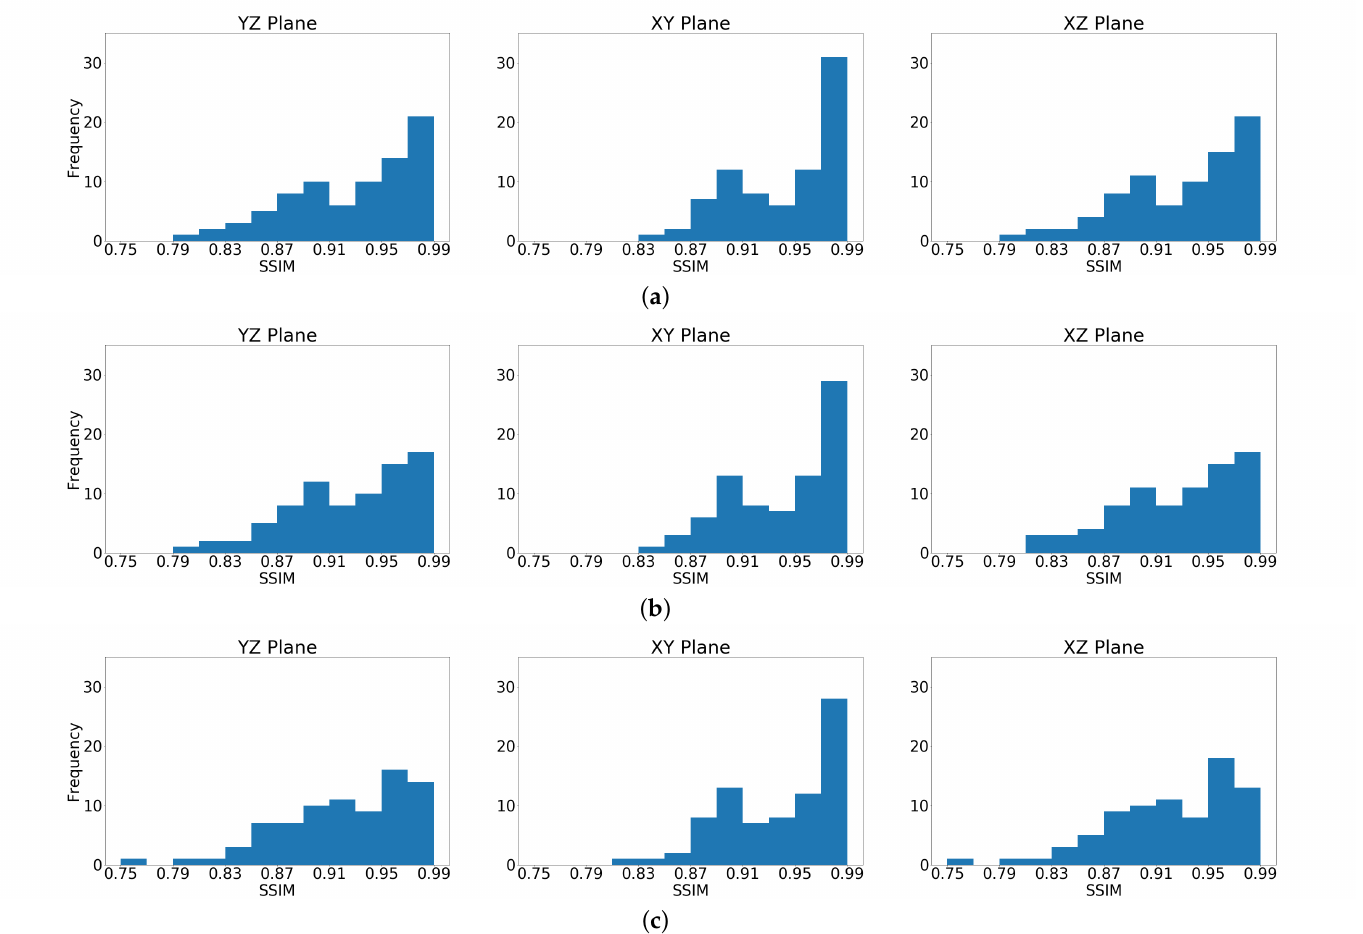
Figure 4. SSIM values histograms of all testing set samples, computed separately along the three 2D planes: ( a ) noiseless data. ( b ) data contaminated by white noise at SNR = 20 dB; and ( c ) data contaminated by field noise at SNR = 20 dB. The histograms clearly indicate that most SSIM values are distributed between 0.80 and 0.99. The average 3D SSIM values are 0.9335 for the noiseless case, 0.9316 with white noise (SNR = 20 dB) and 0.9271 with field noise (SNR = 20